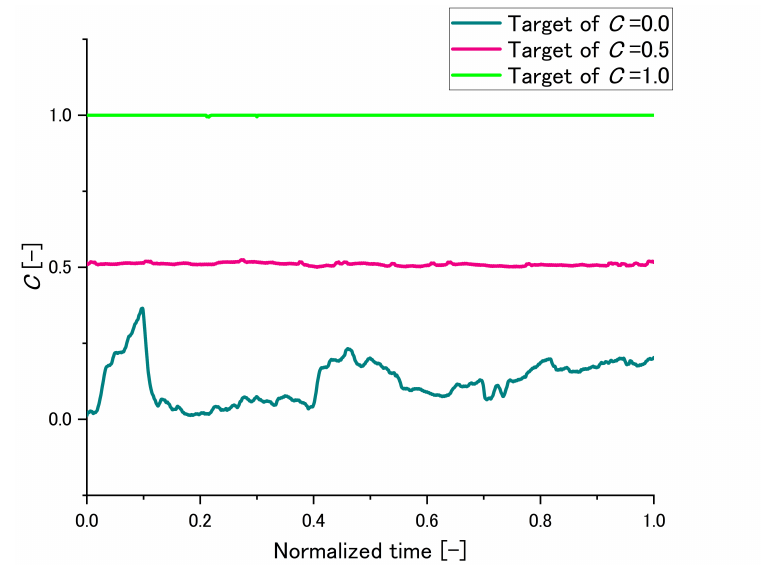
Figure 7. An example of maintaining C of Subject E.